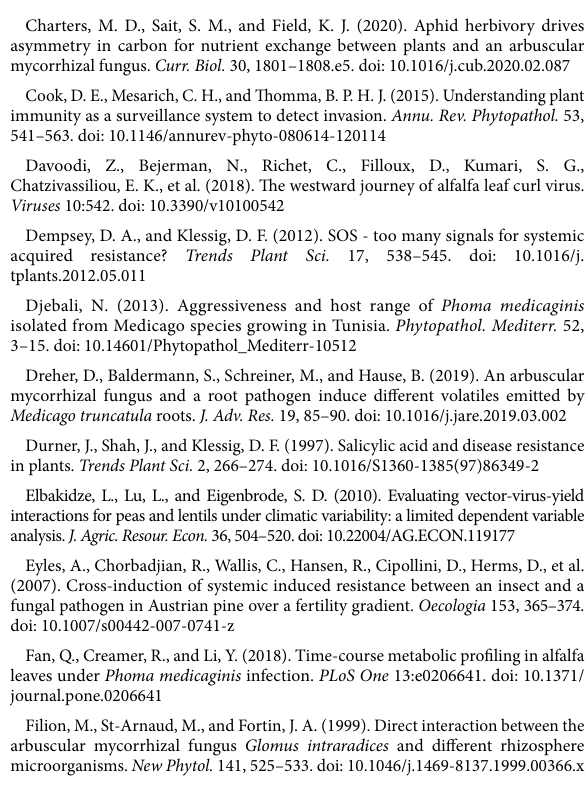
SUPPLEMENTARY FIGURE S3 Gene expression levels obtained from RNA-Seq (blue) and qRT-PCR data (red) of seven genes in all treatments. The left y -axis shows the qRT-PCR data (2 −∆∆ C q ). The right y -axis shows the RNA-Seq data (FPKM). FPKM, fragments per kilobase of exon per million mapped reads; qRT-PCR, real-time quantitative reverse-transcription